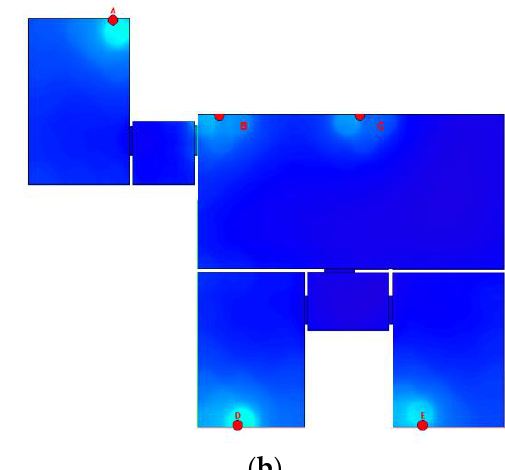
Figure 19. Four-room apartment. Day configuration: ( a ) all CVM on, ( b ) only living room-kitchen CVM on.